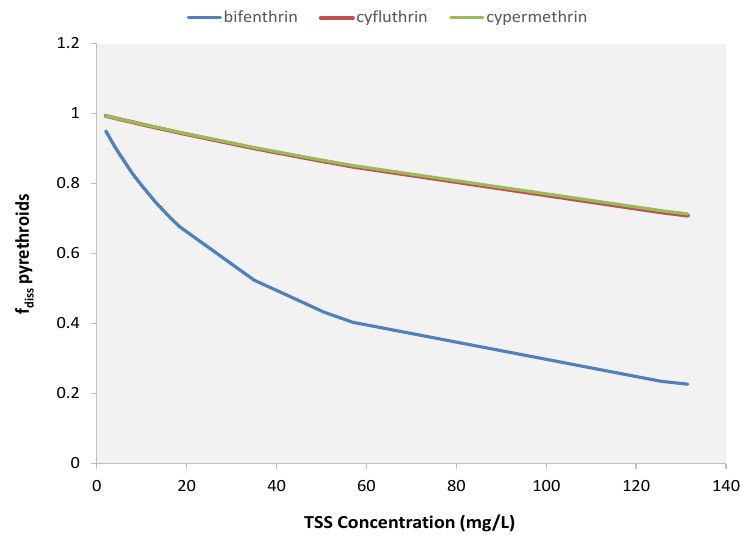
Figure 5. Correlation between TSS concentration and the fraction of dissolved pyrethroids.